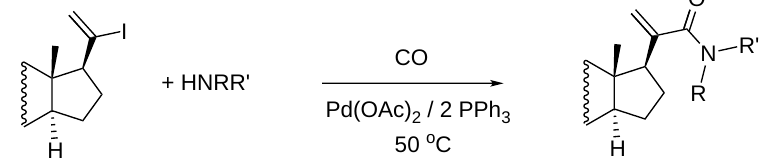
Figure 17. Aminocarbonylation of iodoalkenes affording 20-carboxamides.